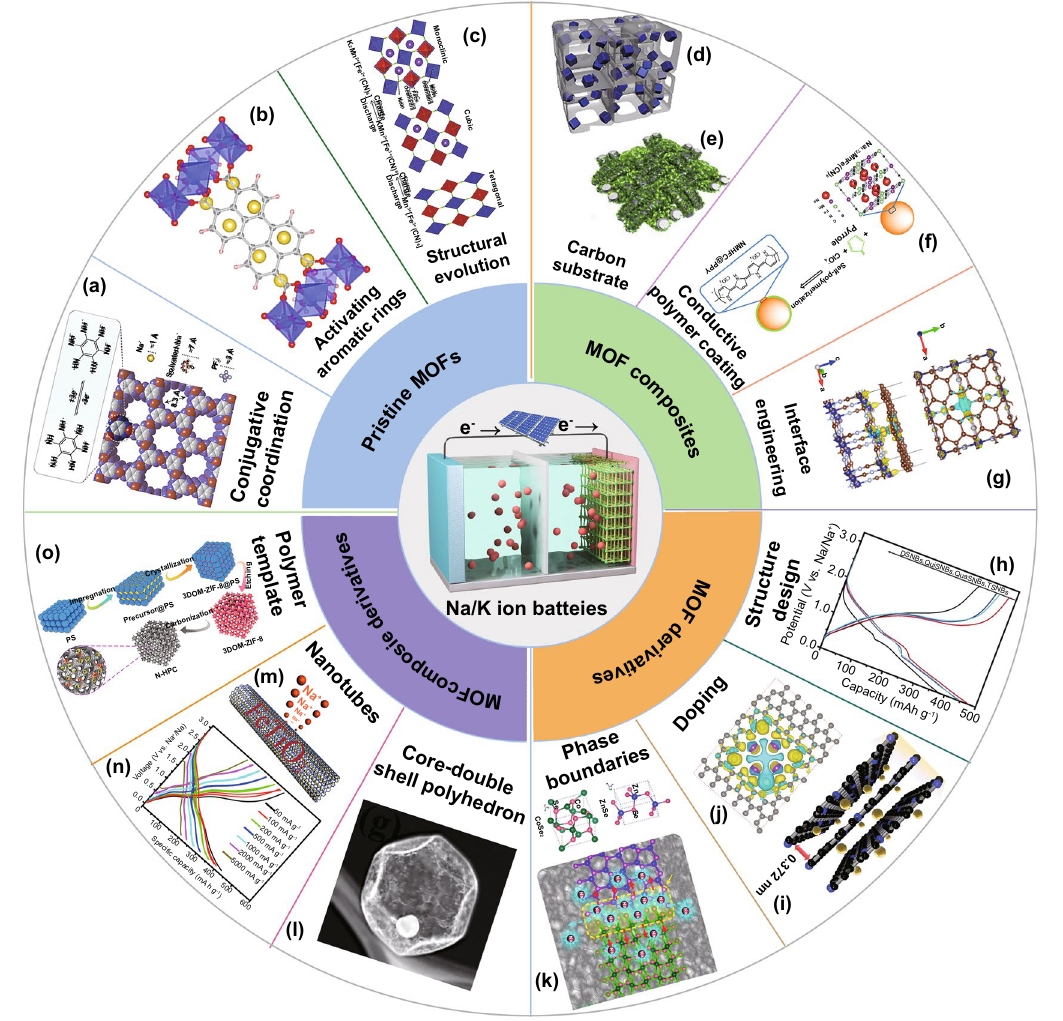
Fig. 4 MOF-related materials for SIBs and PIBs. a Expected three electron reversible reaction and calculated structure of Co-HAB [110]. Cop- yright © 2018, American Chemical Society. b The most stable position of Na + insertion in Zn-PTCA [111]. Copyright © 2018, Elsevier. c Crystal structures and phase transition during charging/discharging processes [145]. Copyright © 2017, Royal Society of Chemistry. d Sche- matic illustration of NaK-MnHCF@3DNC [116]. Copyright © 2019, Elsevier. e Schematic illustration of preparation NiCo-MOF cathode [151].